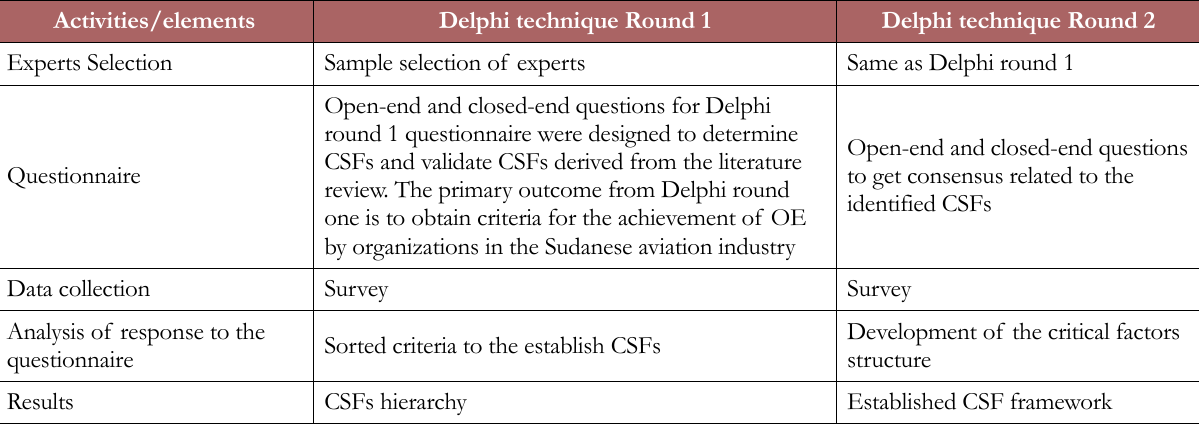
Table 9. The main activities and elements of Delphi round 1 and